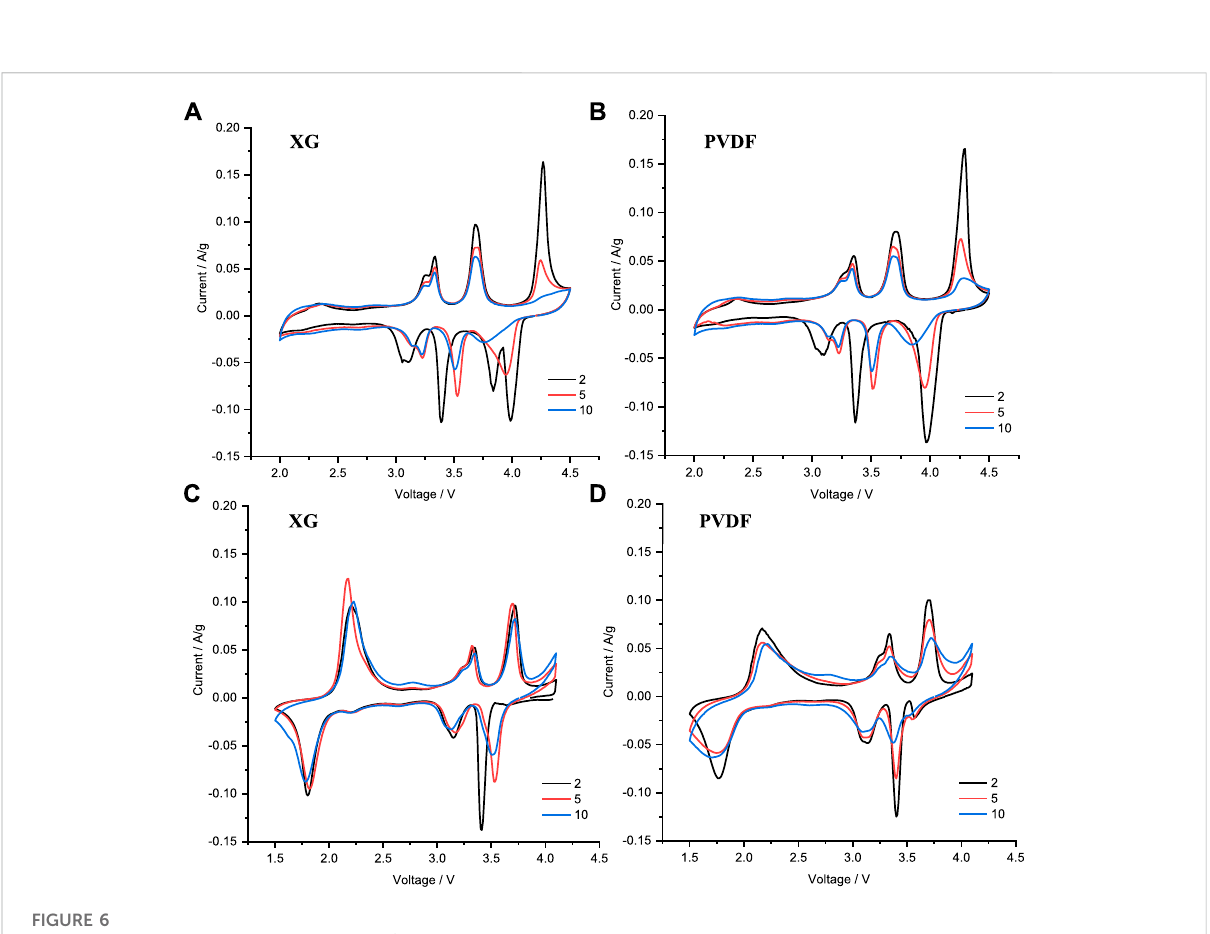
FIGURE 6 Cyclic voltammograms recorded at 0.1 mV s − 1 for cells containing P3-NNM with (A,C) XG and (B,D) PVDF. Cells were cycled between (A,B) 2.0 and 4.5 V or between (C,D) 1.5 and 4.1